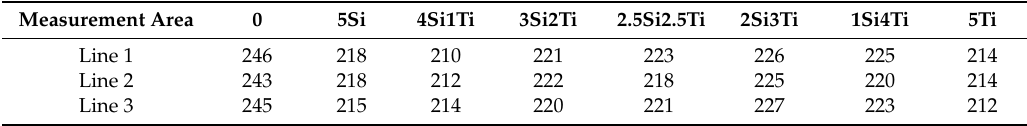
Figure 6. Microhardness values measured in Line 1 and Line 2: ( a ) specimen 0; ( b ) specimen 5Si; ( c ) 4Si1Ti; ( d ) 3Si2Ti; ( e ) 2.5Si2.5Ti; ( f ) 2Si3Ti; ( g ) 1Si4Ti; ( h ) 5Ti. Table 1. Average microhardness values for Lines 1, 2, and 3 measured in the weld